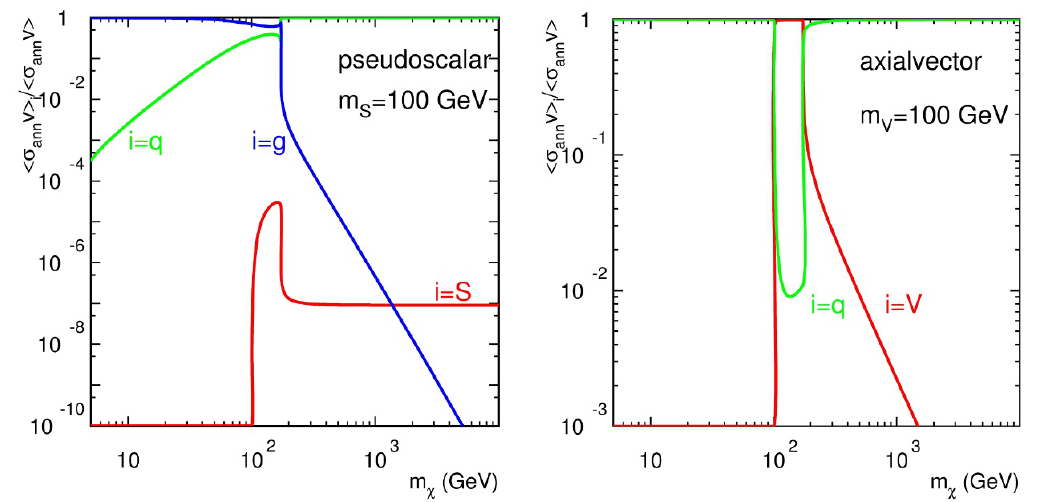
Figure 1 . The annihilation cross section fractions h (cid:27) ann v i i = h (cid:27) ann v i as a function of m (cid:31) for the pseudoscalar mediator case (left) and the axialvector mediator case (right). The mediator mass is (cid:12)xed to be 100 GeV.